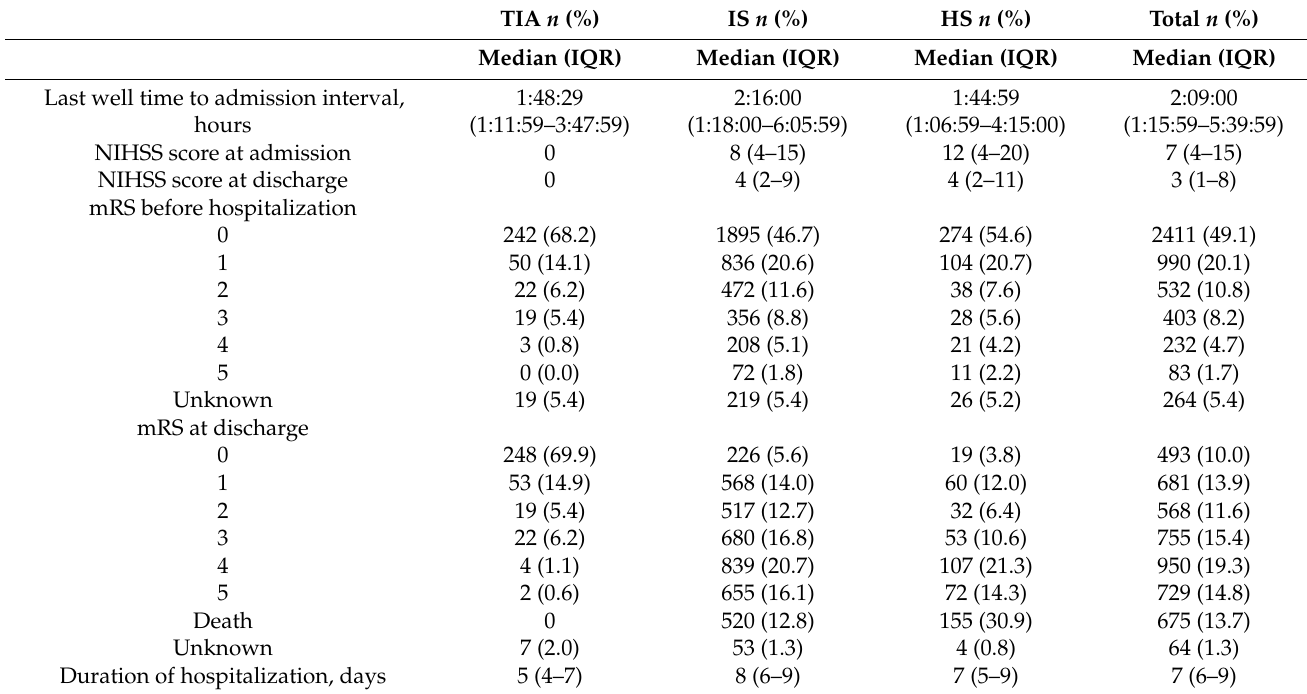
Table 6. Duration of hospitalization, stroke severity on the National Institute of Health Stroke Scale (NIHSS), and functional outcome on the